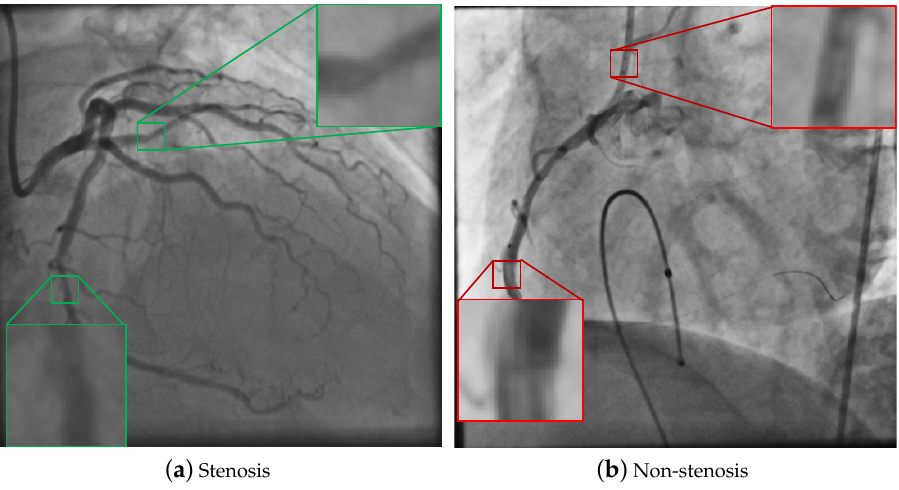
Figure 1. X-ray coronary angiography images. ( a ) The visible stenosis regions are marked in green, and ( b ) the non-stenosis regions are marked in